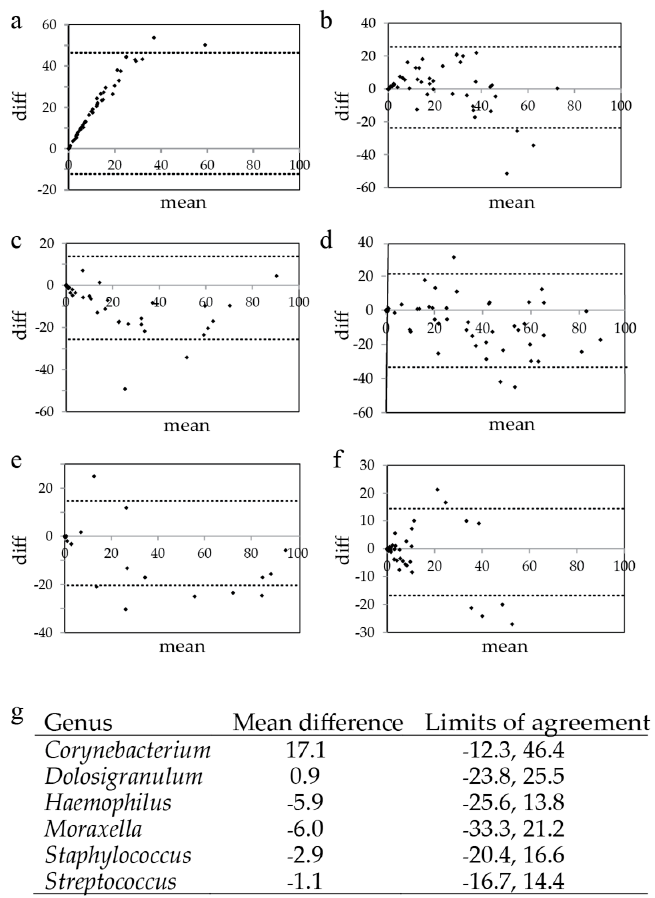
Figure 2. Bland–Altman plots of six main genera present in the nasal microbiota. Bland–Altman plots were generated for the six main genera: ( a ) Corynebacterium , ( b ) Dolosigranulum , ( c ) Haemophilus , ( d ) Moraxella, ( e ) Staphylococcus , and ( f ) Streptococcus. For each genus, the mean difference between the two sequence methods (Illumina versus nanopore) and the limits of agreement (95% reference interval) were calculated and shown ( g ).